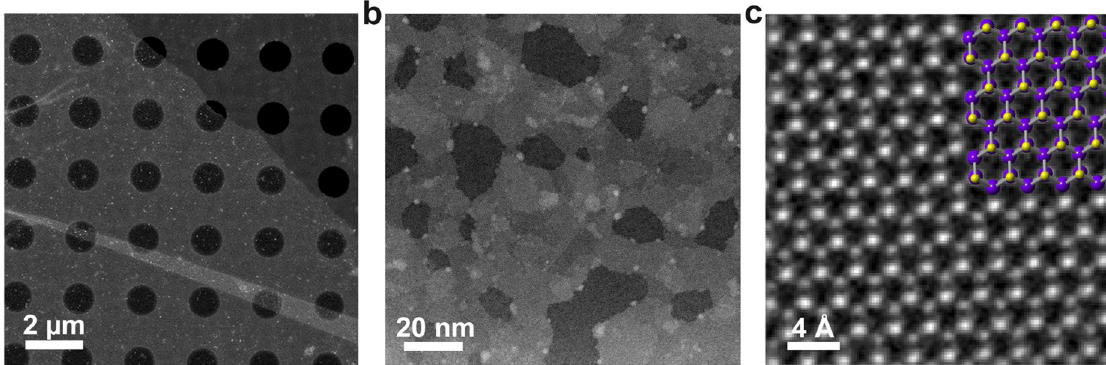
Figure 8. ADF-STEM images of synthesized MoS 2 at various magnifications ( a ) Low magnification image showing a large synthesized and transferred continuous MoS 2 film. ( b ) Intermediate magnification image showing regions of various thicknesses as indicated by differences in intensity. ( c ) High magnification image showing the hexagonal atomic structure of MoS 2 .